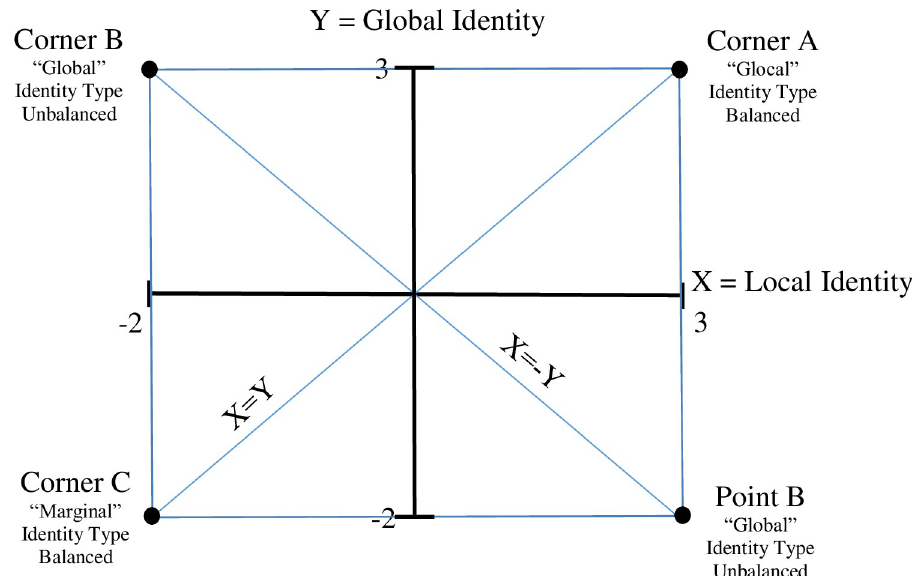
Fig 2. Schematic description of lines of interest between the four identity